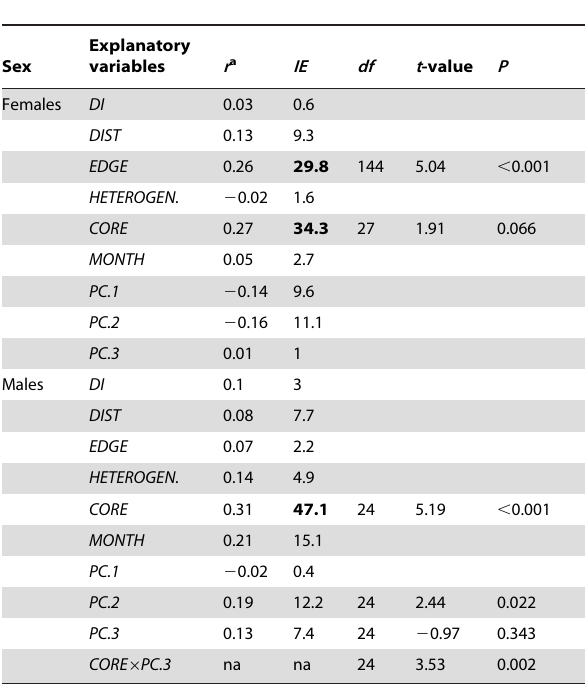
a Pearson’s correlation coefficients ( r ), the independent effect of variables from hierarchical partitioning ( IE ), and results of linear mixed effect model fitting are shown. Degrees of freedom, t -value and P -values are shown for variables that were selected for inclusion in the reduced LMEM using Akaike Information Criterion.